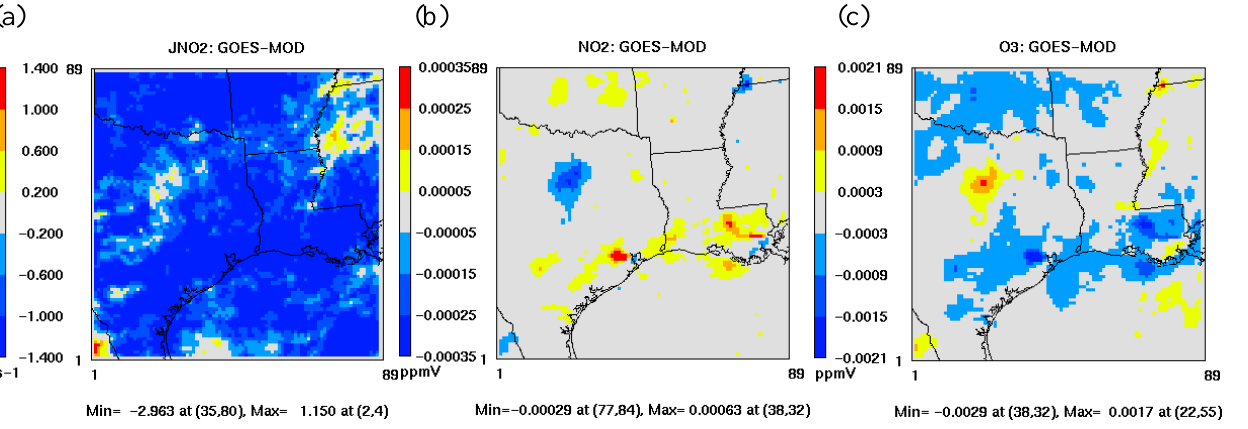
Figure 2. Differences between satellite-derived (GOES) and model-predicted (MOD) J NO at 13:00 on 2 September 2006.